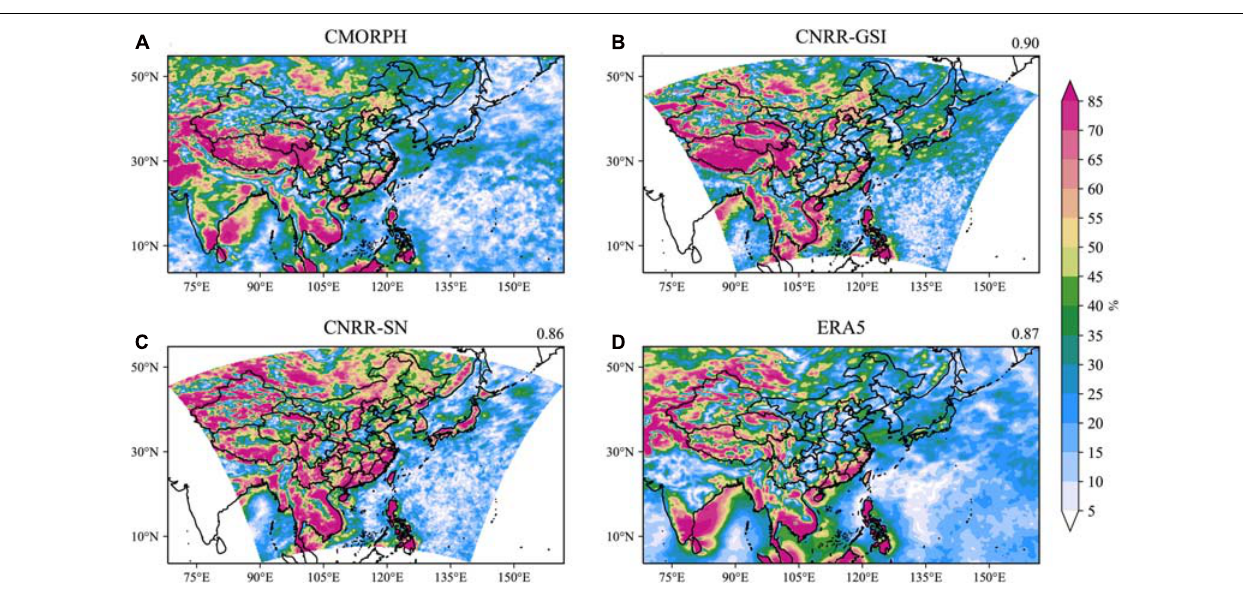
slightly better results than CNRR-SN over South China Sea and Bay of